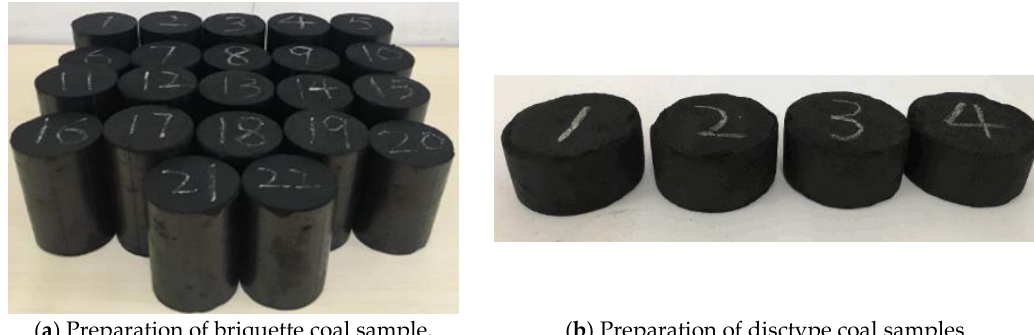
Figure 1. Preparation of briquette coal sample. Table 2. Parameters of cylindrical briquette coal samples.